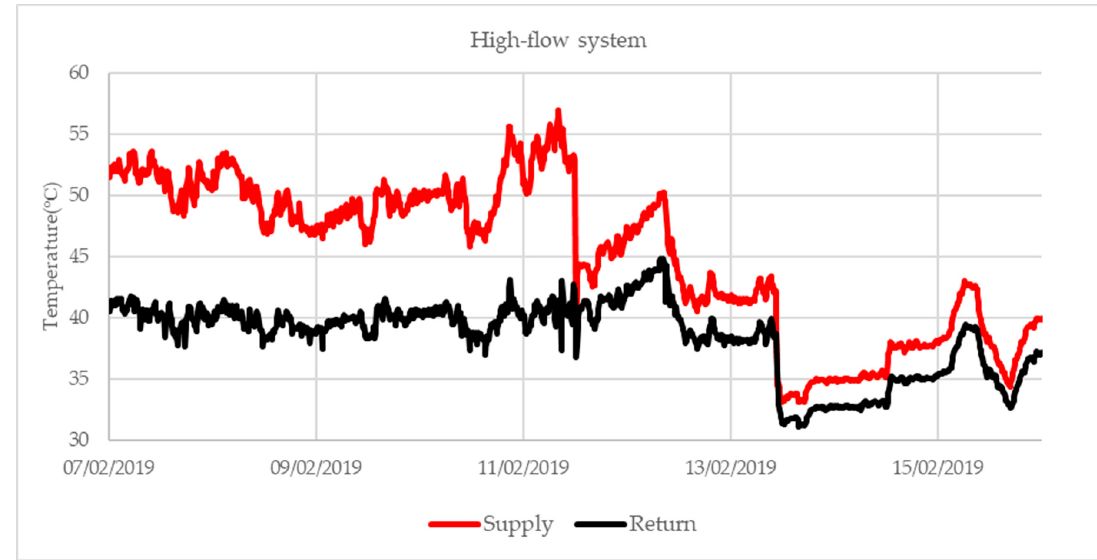
Figure 17. Results of the second strategy based on the high-flow system operation tested under two steps on 11 February 2019 and 13 February 2019 in the actual radiator system of the building case study in Viborg. The two curves represent the supply and the return temperature of the radiator system.